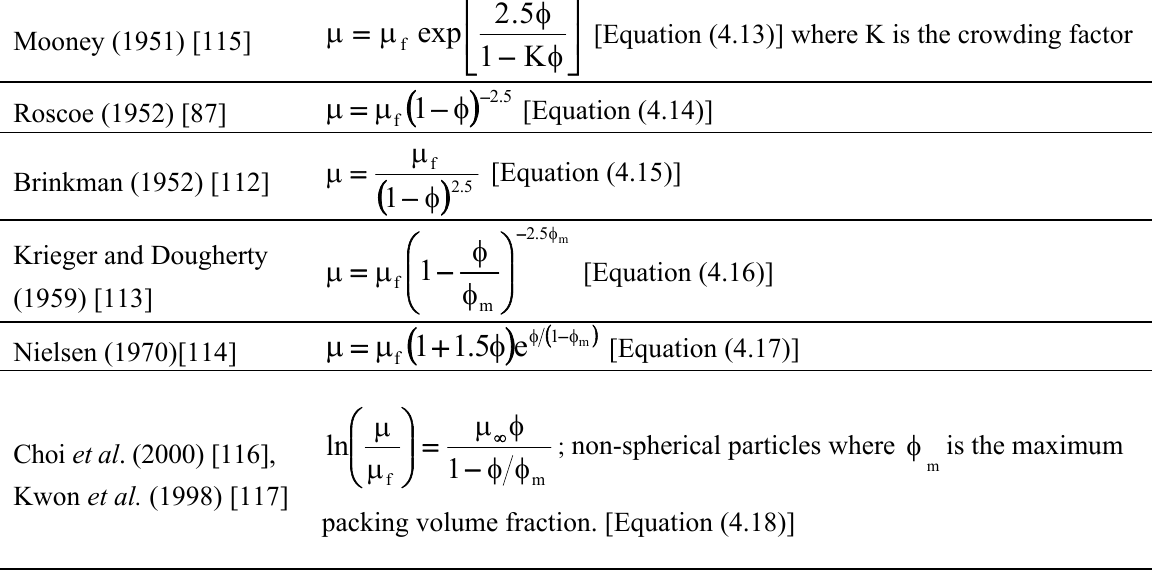
Table 2. Additional correlations for the viscosity as a function of